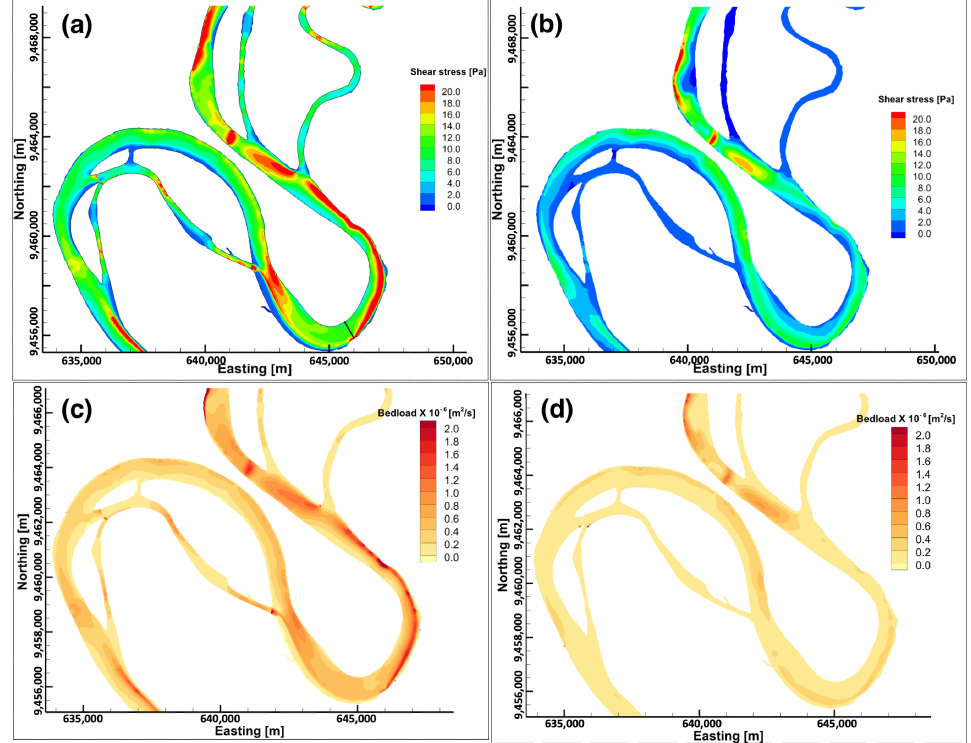
Figure 12. Shear stresses computed with the numeric model, ( a ) high flow conditions, ( b ) and low flow conditions. Bedload sediment transport rate, ( c ) high flow conditions, and ( d ) low flow